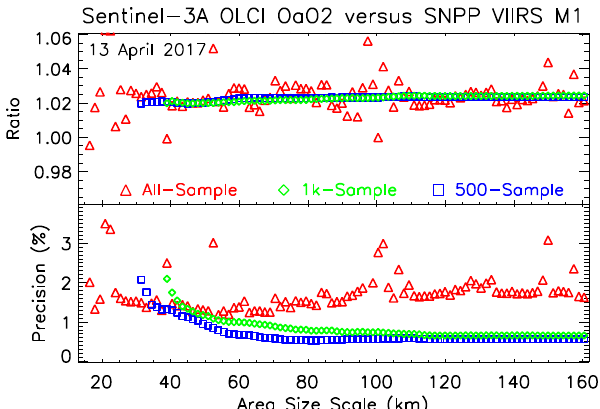
Figure 17. The scale-dependent result of radiometric comparison of Sentinel-3A OLCI Oa02 versus SNPP VIIRS M1 for the 13 April 2017 event for ratio (top panel) and the error bar (bottom panel) shown for the three cases of unconstrained sample size (red triangles), constrained size at 1000 samples (blue squares), and constrained size at 500 samples (green diamonds).